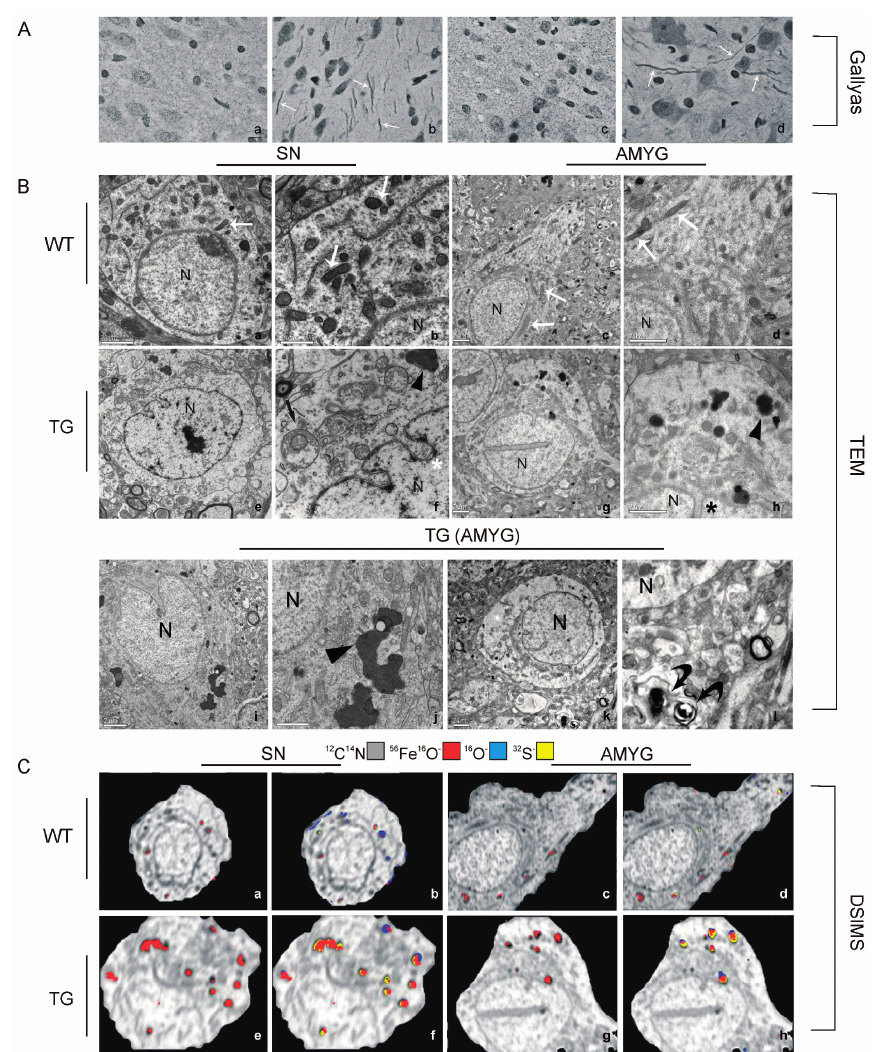
Figure 5. Neurohistopathology of 48 week-old GFAP.HMOX1 and wild-type (WT) mice. ( A ) Gallyas silver staining demonstrating abundant neuritic damage (arrows) in the GFAP.HMOX1 substantia nigra (SN; a ) and amygdala (AMYG; d ) but not in respective WT preparations ( a , c ). Magnification bar = 10 μ m; ( B ) GFAP.HMOX1 and WT brain ultrastructure. Fields depicted in a , c , e , g are shown at higher magnifications in panels b , d , f and h , respectively. GFAP.HMOX1 astrocytes contain degenerate mitochondria (straight black arrow in f ), autophagic and lipofuscin-like material (arrowheads), and nuclear envelope invaginations (asterisks). These pathological features were not seen in WT preparations. Degenerate neurites (curved arrows in l) were observed in close proximity to pathological astrocytes in TG, but not WT, brains; ( C ) Dynamic secondary ion mass spectroscopy (SIMS) of TG and WT astroglia from substantia nigra (SN) and amygdala (AMYG). Panels a , c , e and g depict FeO, and panels b , d , f and h depict multiple elements of interest, superimposed on cytoarchitecture (gray-scale) visualized by CN mapping. Little to no iron is detectable in WT preparations. Astrocytes in TG substantia nigra and amygdala, but not in respective WT preparations, are replete with iron-laden intracellular inclusions that co-localize with oxygen and sulphur. (Panels A and B from [65]; Panel C from [66], with